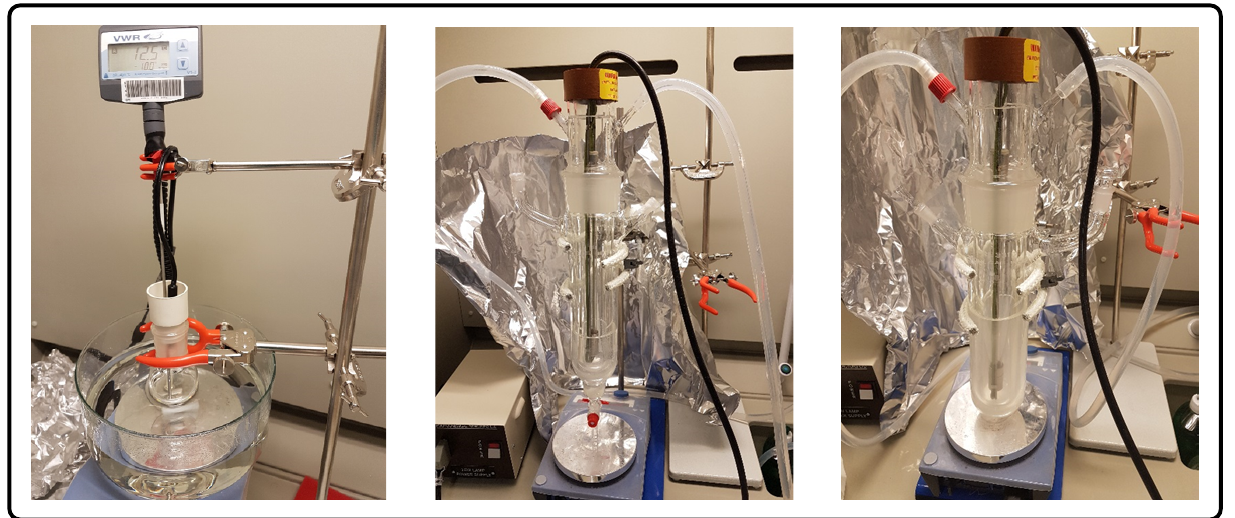
Figure 3. Reactors used. ( Left )—roundbottom flask with Pen-Ray lamp inserted, in water bath. ( Center )—immersion well reactor. ( Right )—the configuration of the reactor resulted in limited space available for the stirrer magnets, therefore the reactor flask was modified with the bottom tap of the reactor